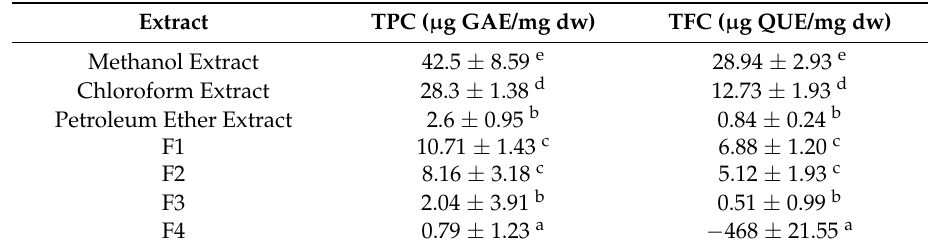
Table 1. Estimation of total phenolic and flavonoid contents of various extracts and fractions of E. spiralis stem